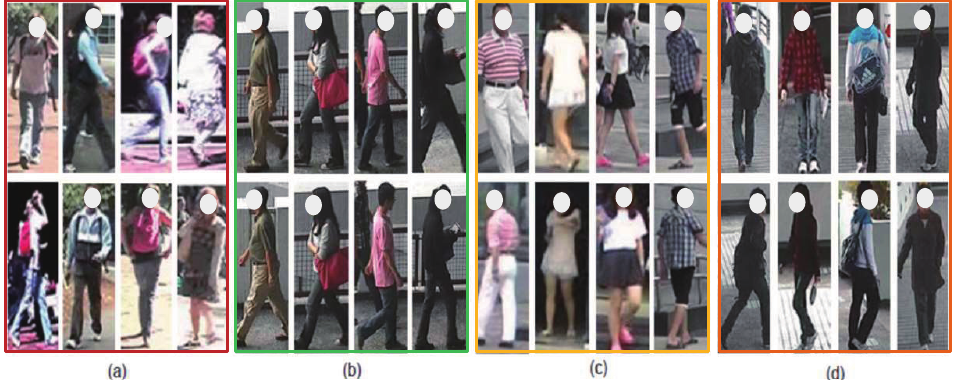
Figure 7. Some typical samples from three public datasets. Each column shows two images of the same person from two different cameras under significant changes of the scale and illumination. ( a ) VIPeR dataset exhibits significant differences between different views. ( b ) CUHK-03 dataset with labeled version. ( c ) Market-1501 dataset has significant and consistent lighting changes. ( d )